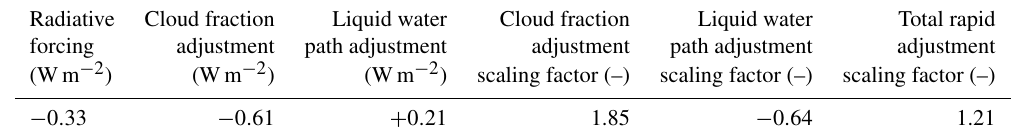
Table 10. Radiative forcing of aerosol–cloud interactions and cloud fraction and liquid water path adjustments, estimated using satellite retrieval statistics by Gryspeerdt et al. (2019). The scaling factors for each rapid adjustment and the total rapid adjustment are also provided. Values are for all present-day anthropogenic